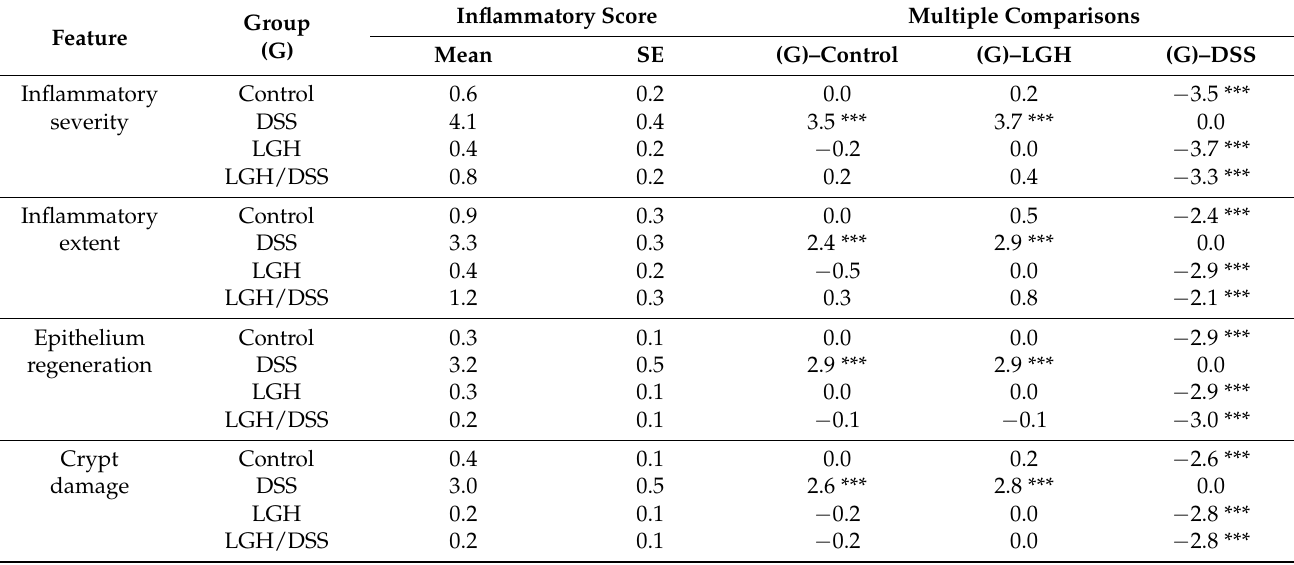
Table 2. Multiple comparisons of histological assessment of